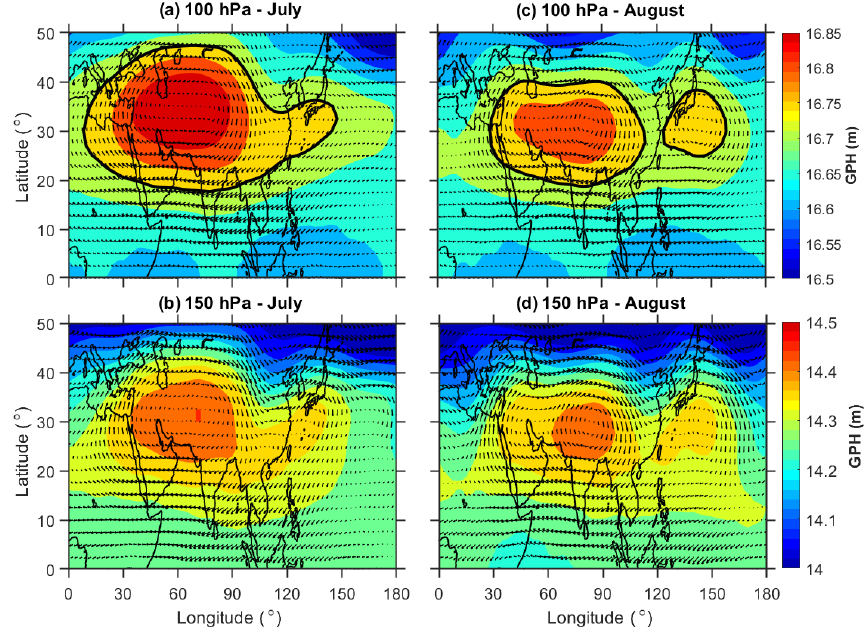
Figure 2. Spatial distribution of geopotential height obtained from NCEP-DOE Reanalysis 2 data during July 2015 at (a) 100hPa and (b) 150hPa superimposed with wind vectors at the respective corresponding levels. Subplots of (c) and (d) are the same as (a) and (b) but for the month of August. The solid black contour lines represent the ASMA region at 100hPa (16.75km GPH